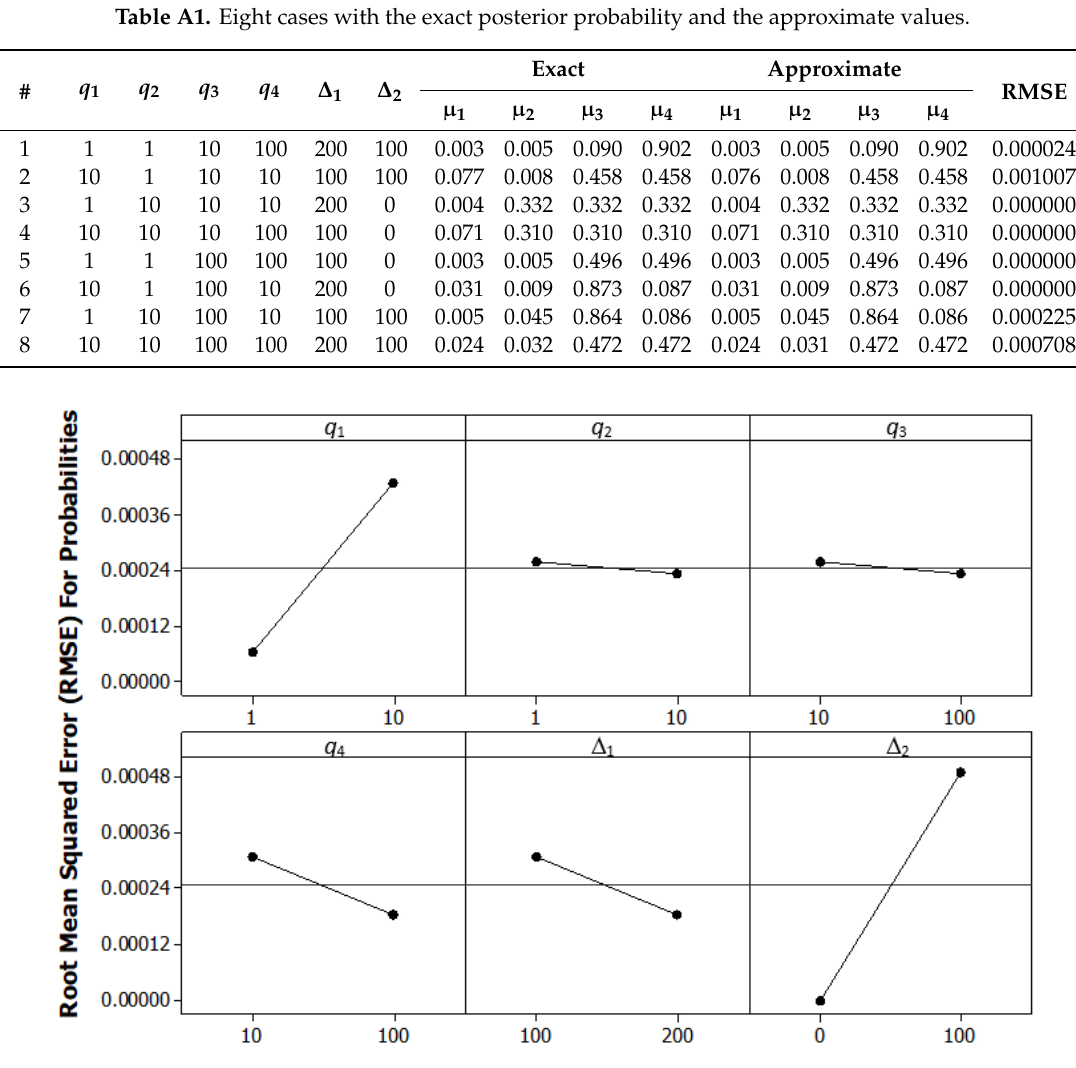
Figure A2. Main e ff ects plot of the Figure A2. Main effects plot of the RMSE.